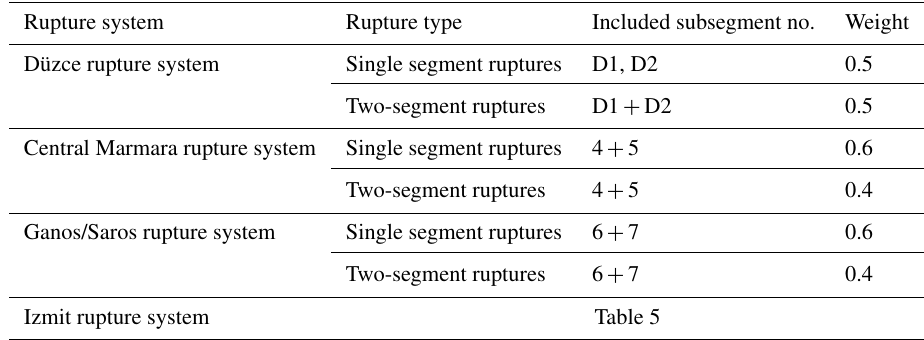
Table 4. Aleatory variability in the rupture scenario weights.